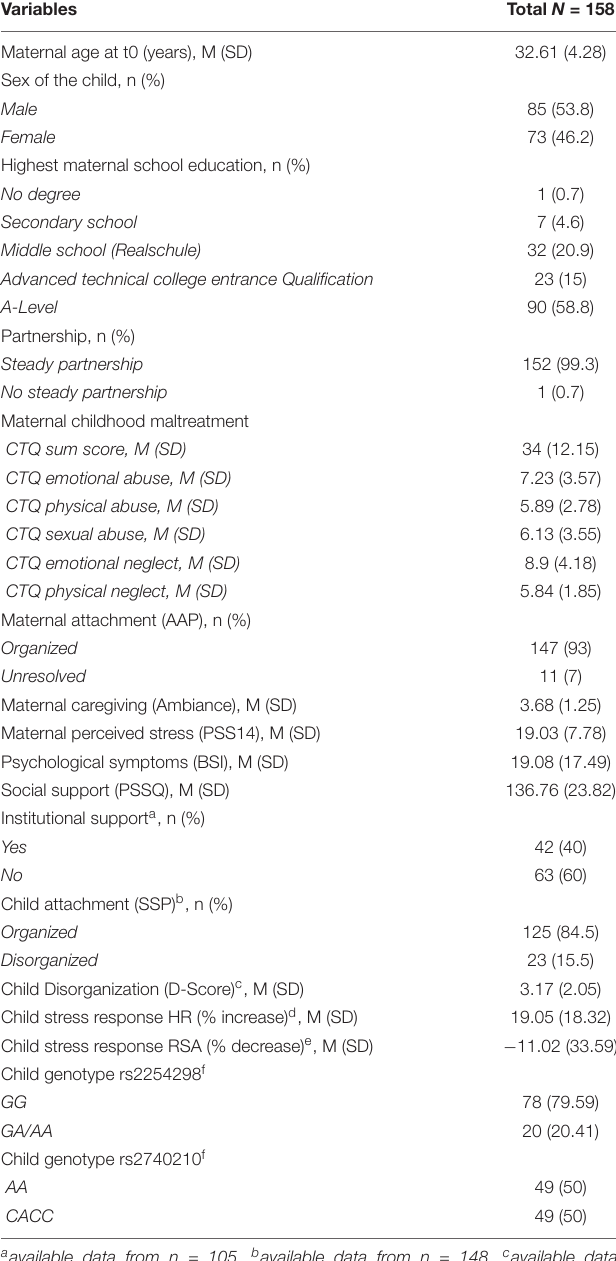
TABLE 1 | Demographics and clinical characteristics of mother-child